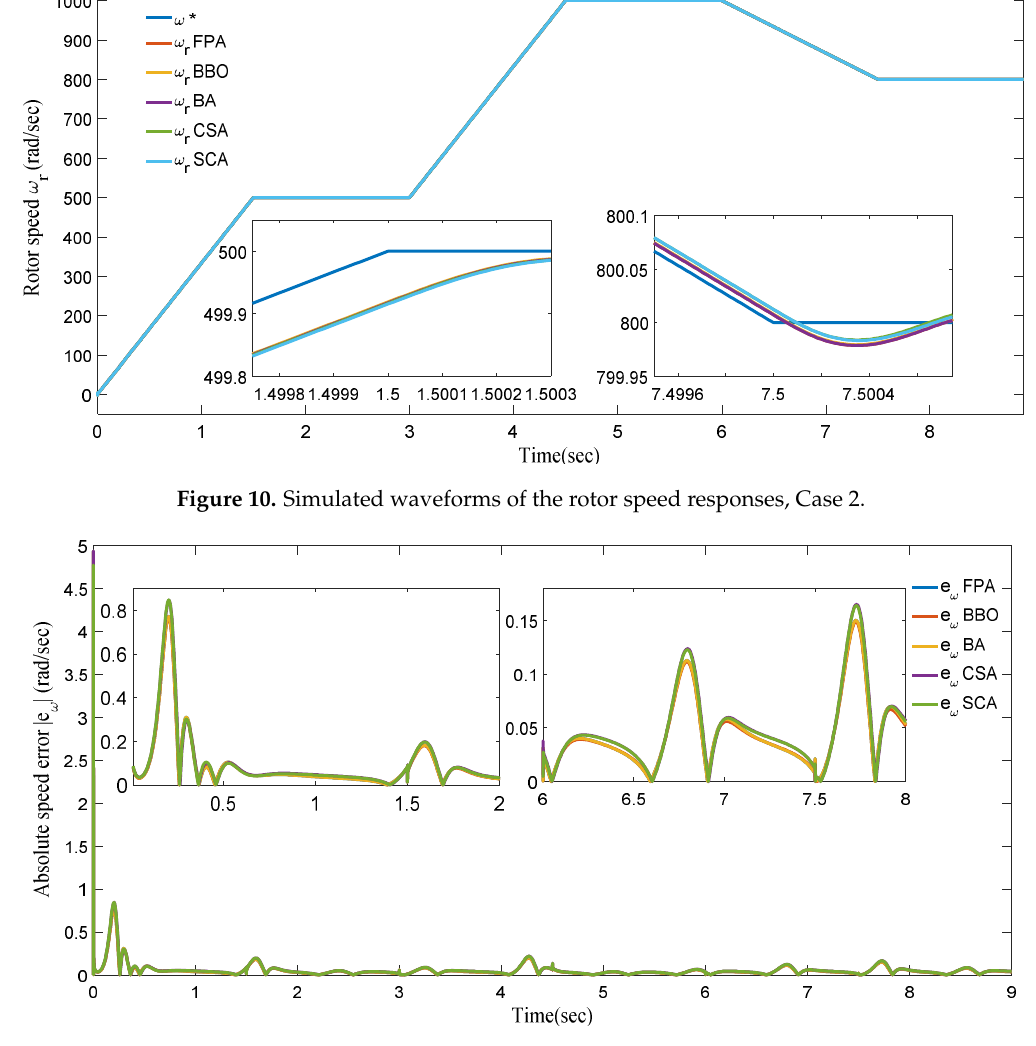
Figure 11. Waveform of the rotor speed error performance, Case 2. Table 6. Performance indices of PI controllers tuned using BA, BBO, CSA, FPA and SCA in case 2.